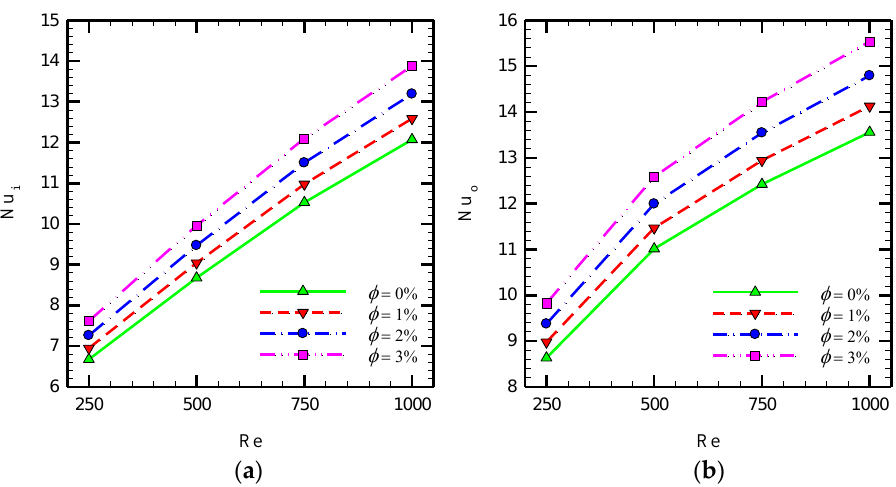
Figure 12. Average Nusselt number for different volume fractions of nanoparticles in terms of Reynolds number for Counter-STT case at ( a ) inner and ( b ) outer tubes of the heat exchanger.